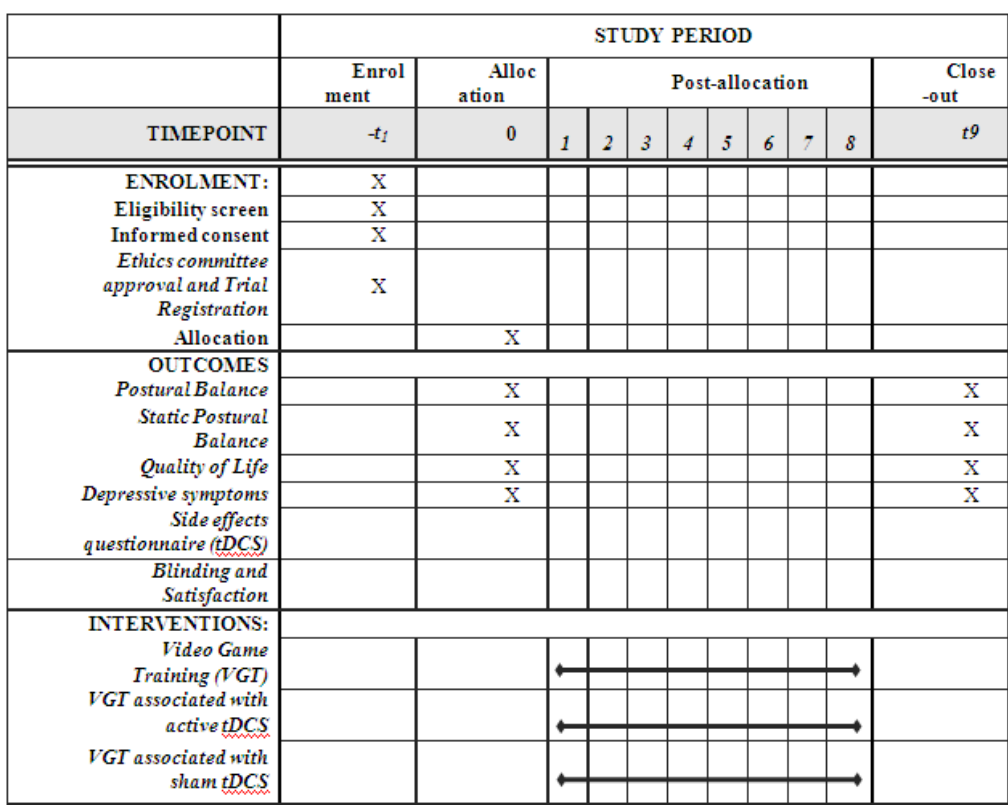
A researcher not involved in evaluations or training will be responsible for allocating participants via